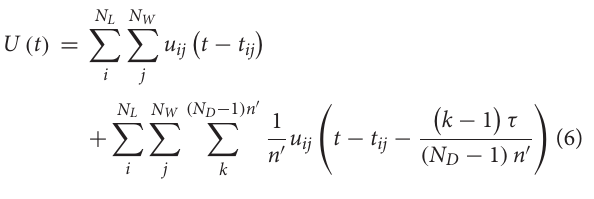
Frontiers in Built Environment |